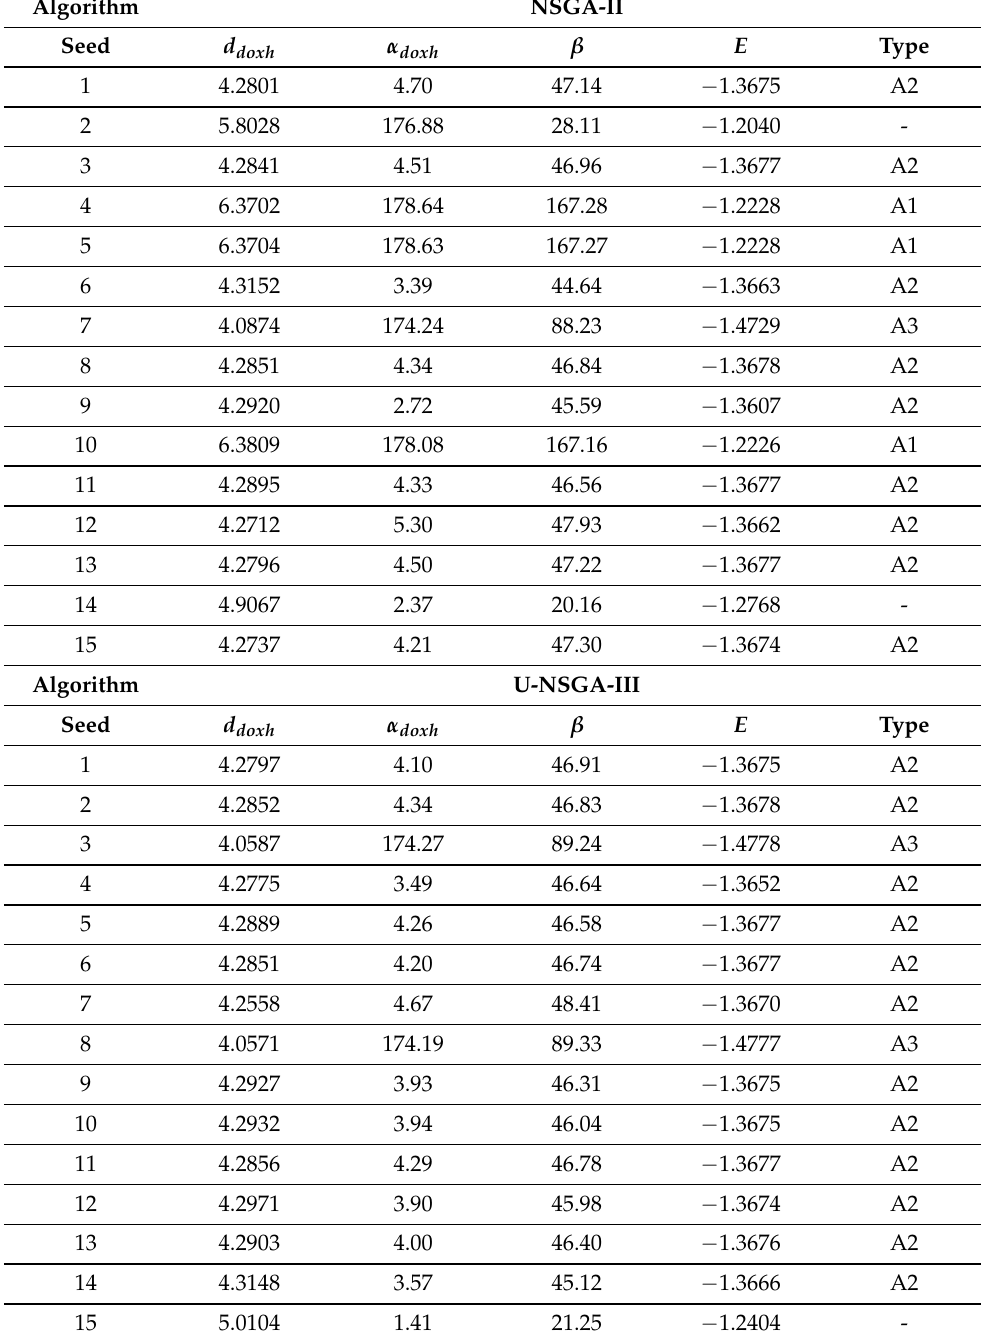
Table 3. Numerical results of closest distance d doxh (Å), incline angle α doxh (degrees), rotational angle β (degrees) and minimum energy E (eV) for interaction between two